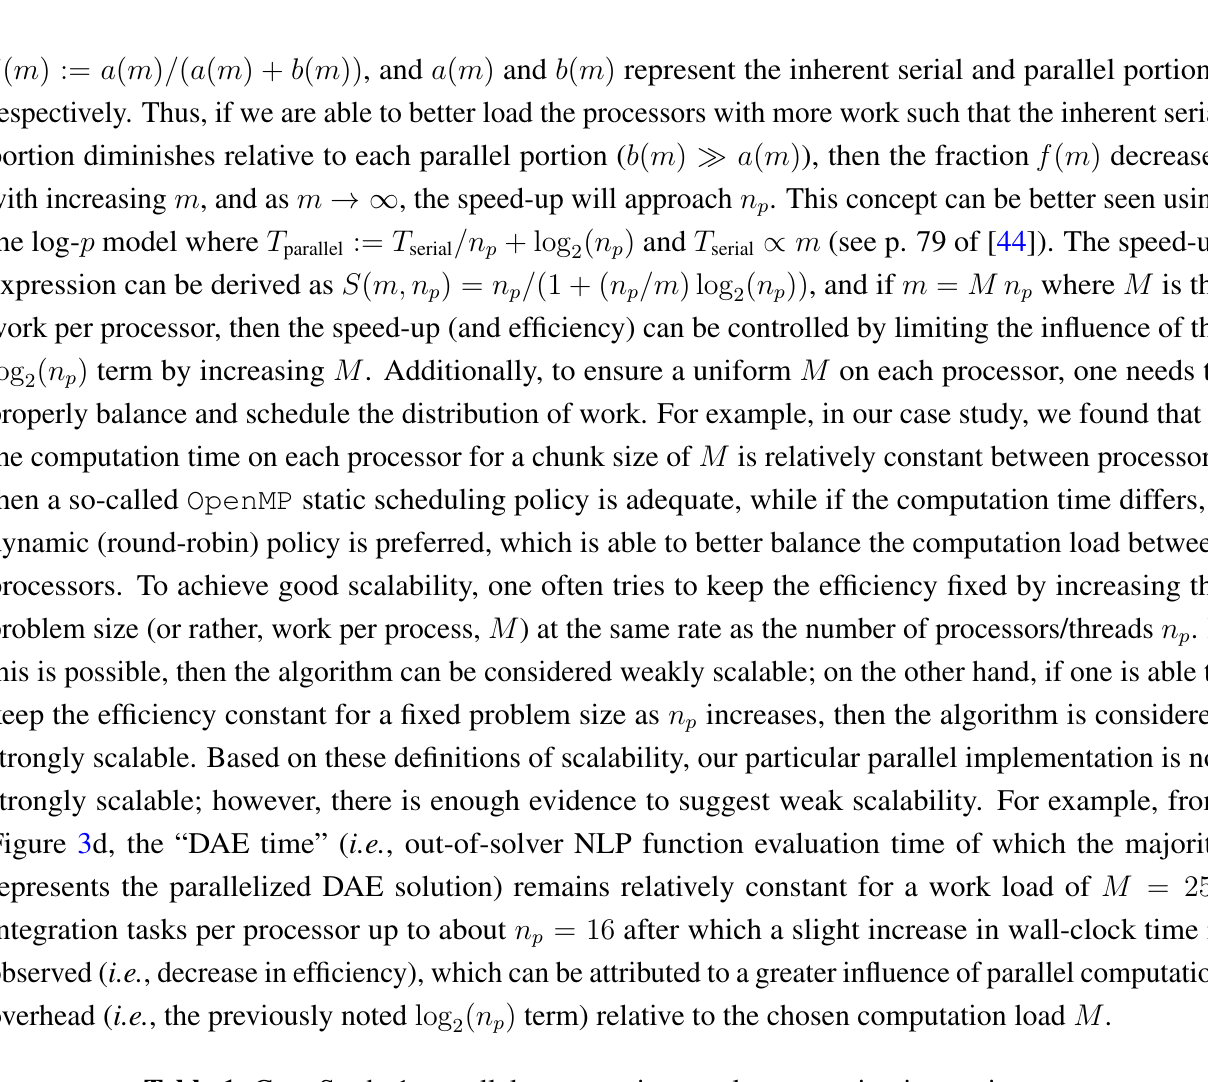
Table 1. Case Study 1: parallel computation results comparing increasing n